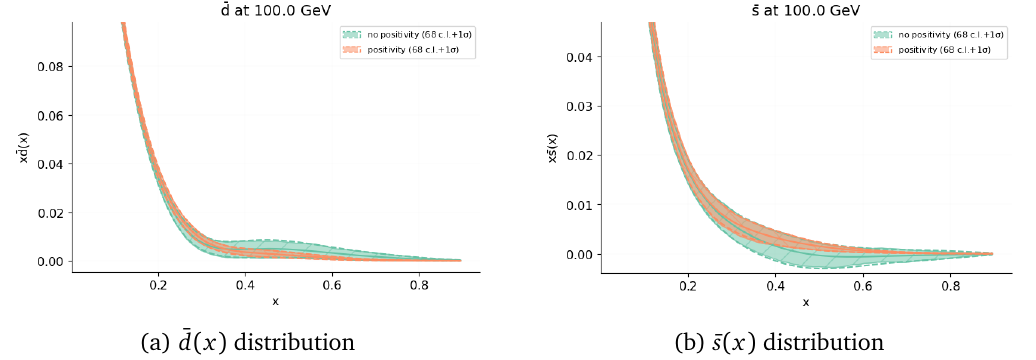
Figure 3: Impact of imposing positivity on two selected PDF distributions at µ =